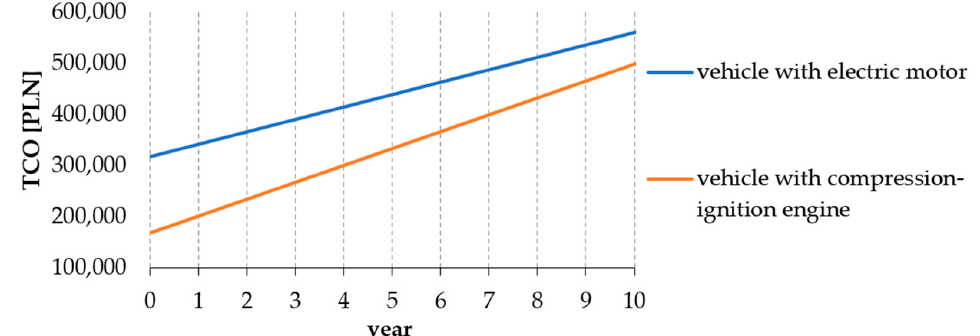
Figure 17. Total cost of ownership of vehicle during the whole operating period—electric vehicle is recharged only at public AC charging stations (the lowest price for 1 kWh was included in the calculations—Scenario A2).